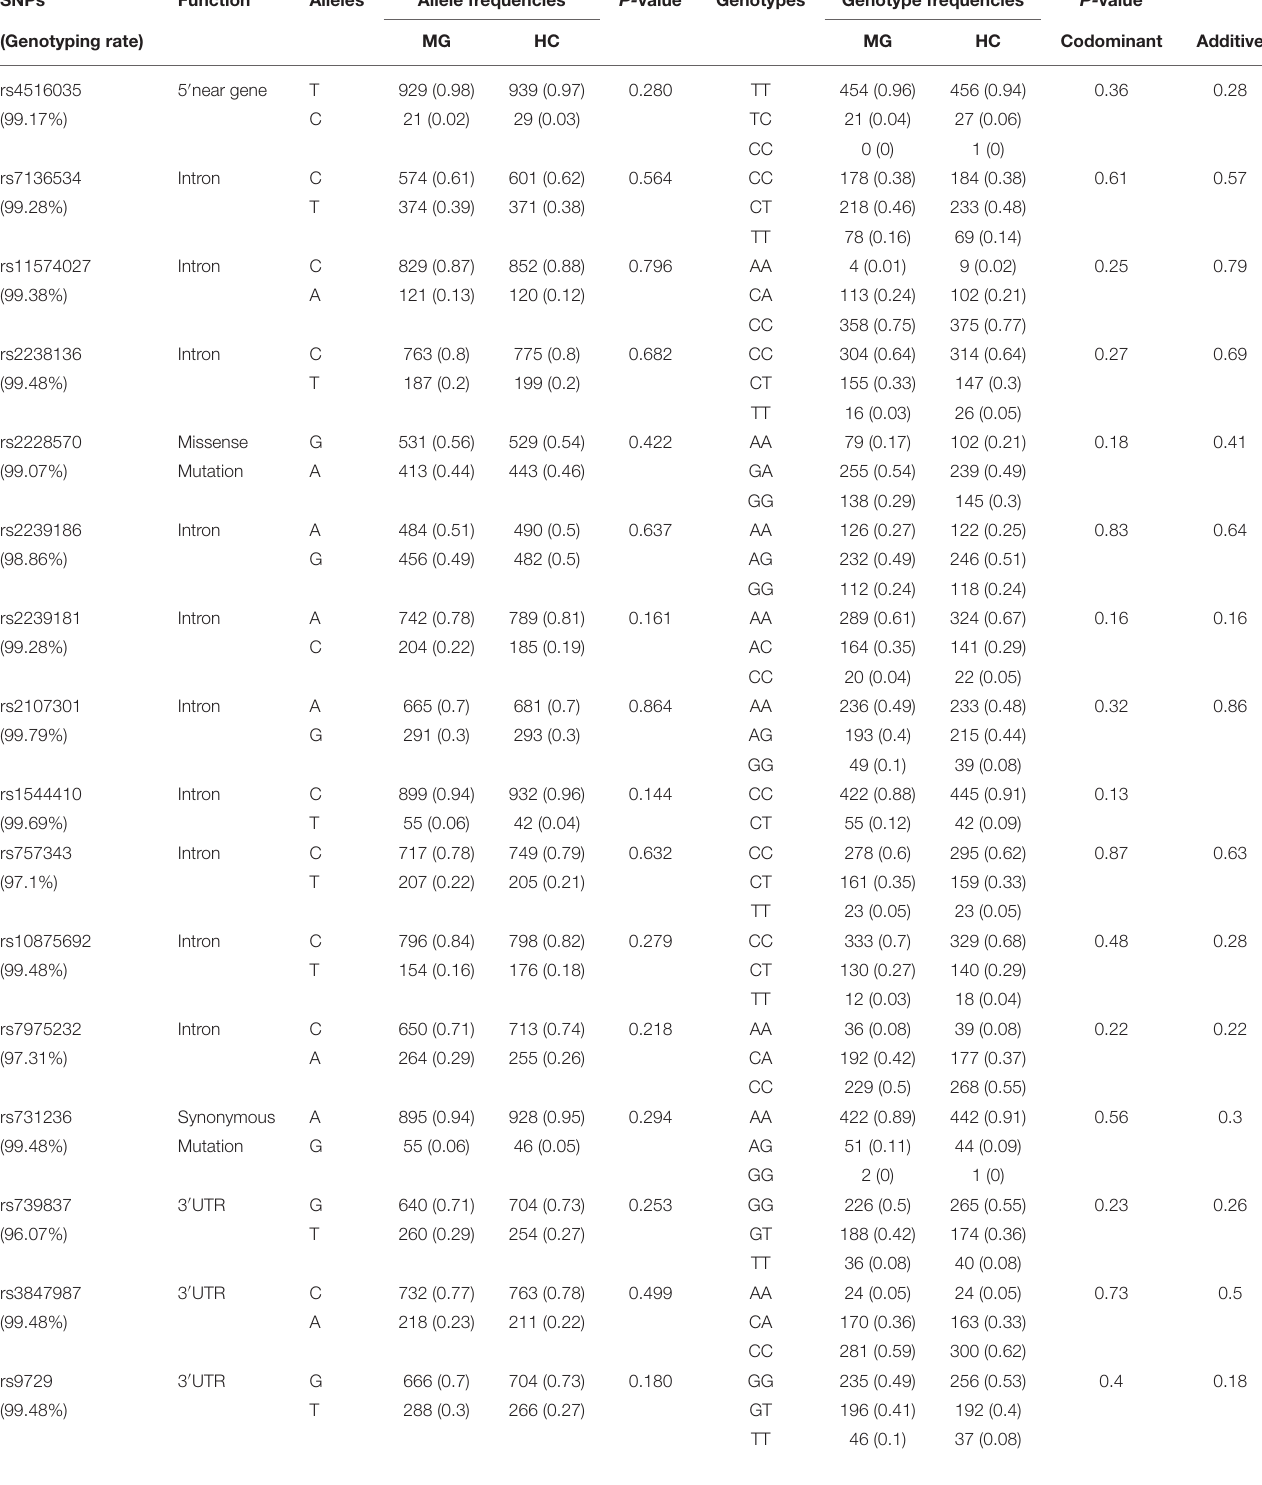
TABLE 1 | General information of SNPs in MG patients and healthy